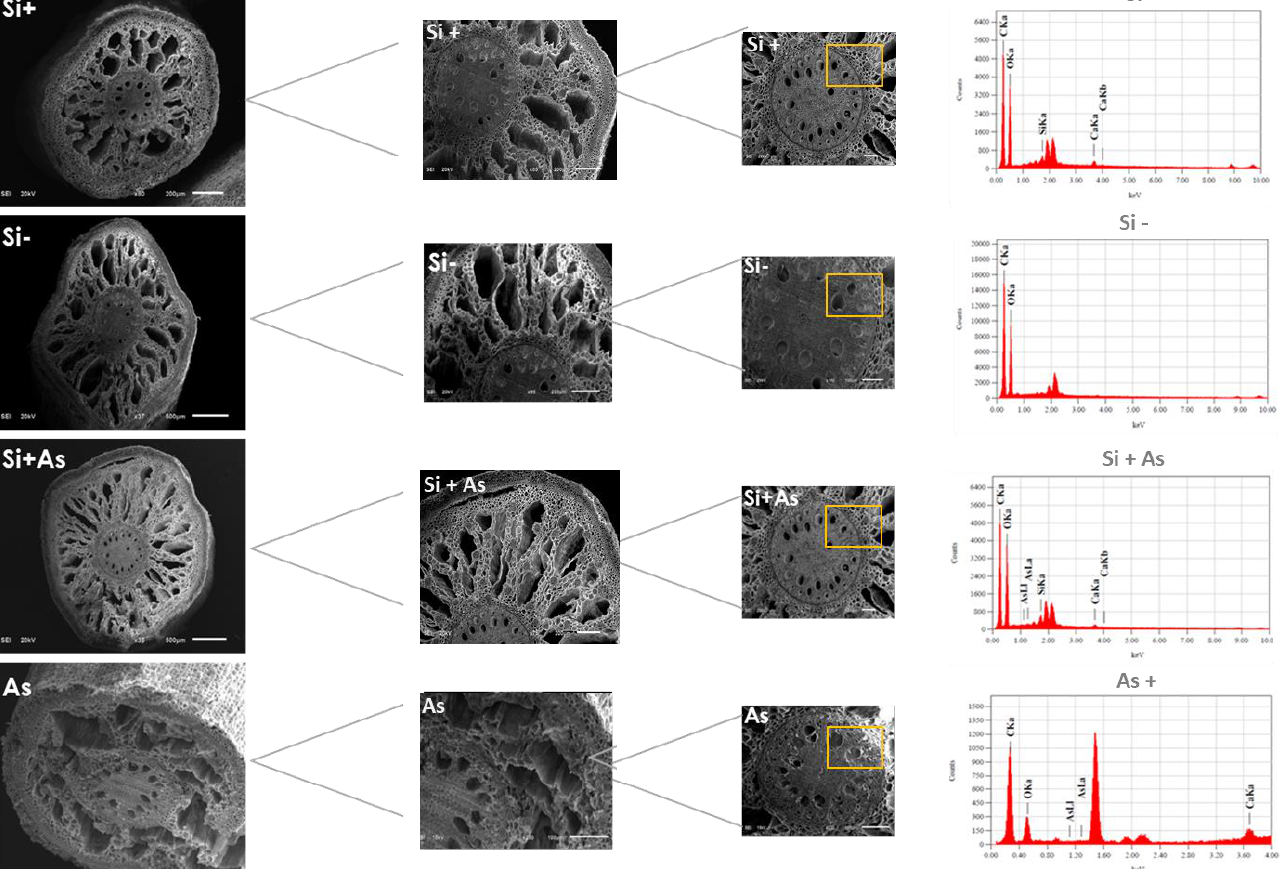
Figure 10. Scanning electron microscopy (SEM) images of date palm roots under different treatments of non-silicon (Si − ), silicon (Si+), combine (Si + As), and arsenic (As). Images represent Si and As effects on roots anatomy from low to higher magnifications, respectively, for Si+, Si-, Si + As, and As. The encircled areas in yellow were selected for EDS-based elemental analysis showing EDX-elemental peaks for Si+, Si-, Si + As, and As-treated plants, respectively. Three biological replicates were screen for each sample.